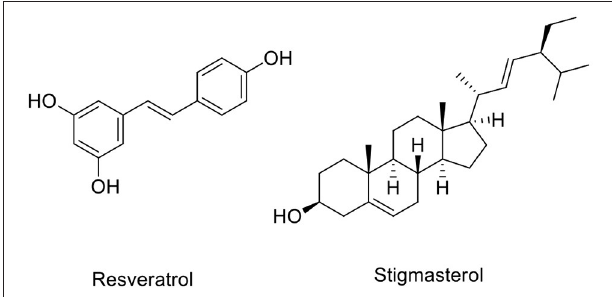
FIGURE 1 | Chemical structures of resveratrol and